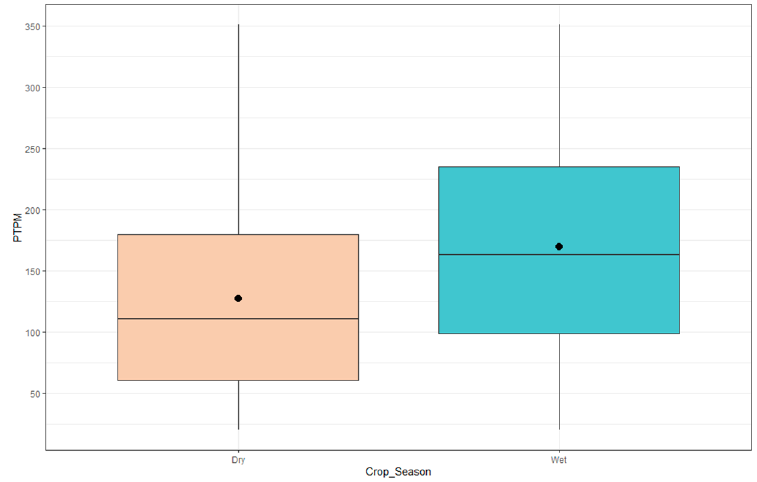
Figure 3. Boxplot of the monthly accumulated precipitation values (2010–2019) in the wet and dry